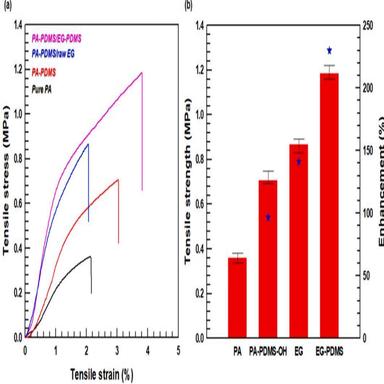
(a,b) Mechanical properties of PA-PDMS composites.